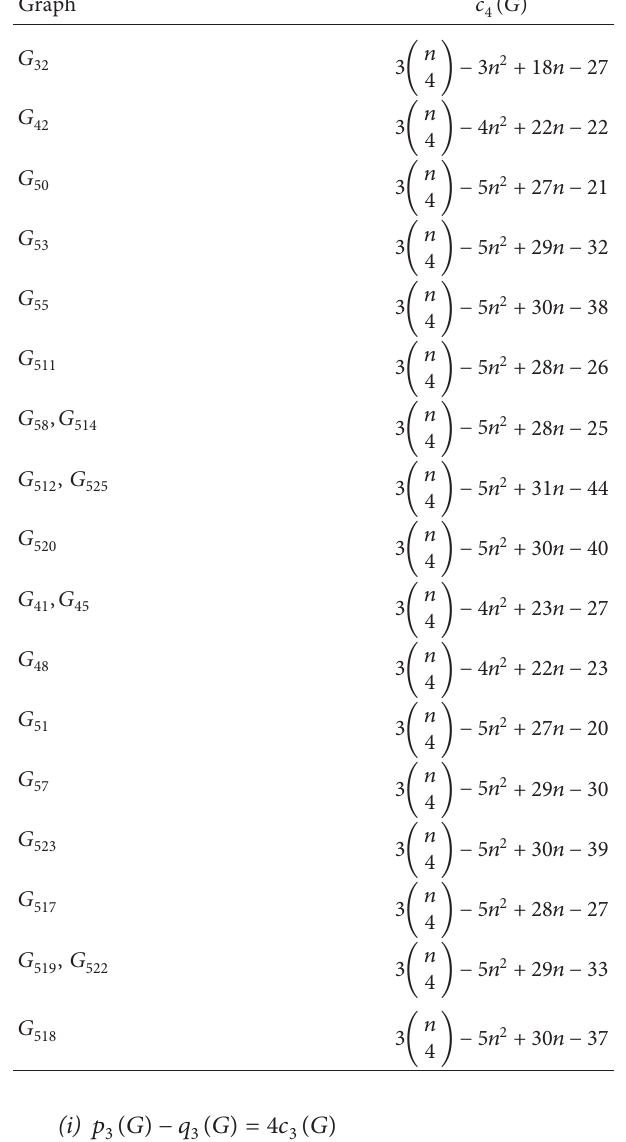
Table 2: The numbers of quadrangles of some graphs in G Graph